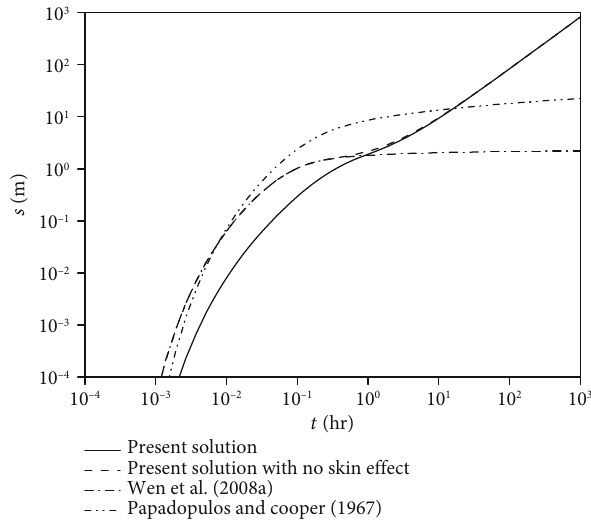
Figure 3: The drawdown behavior in aquifer determined using the present study and the available